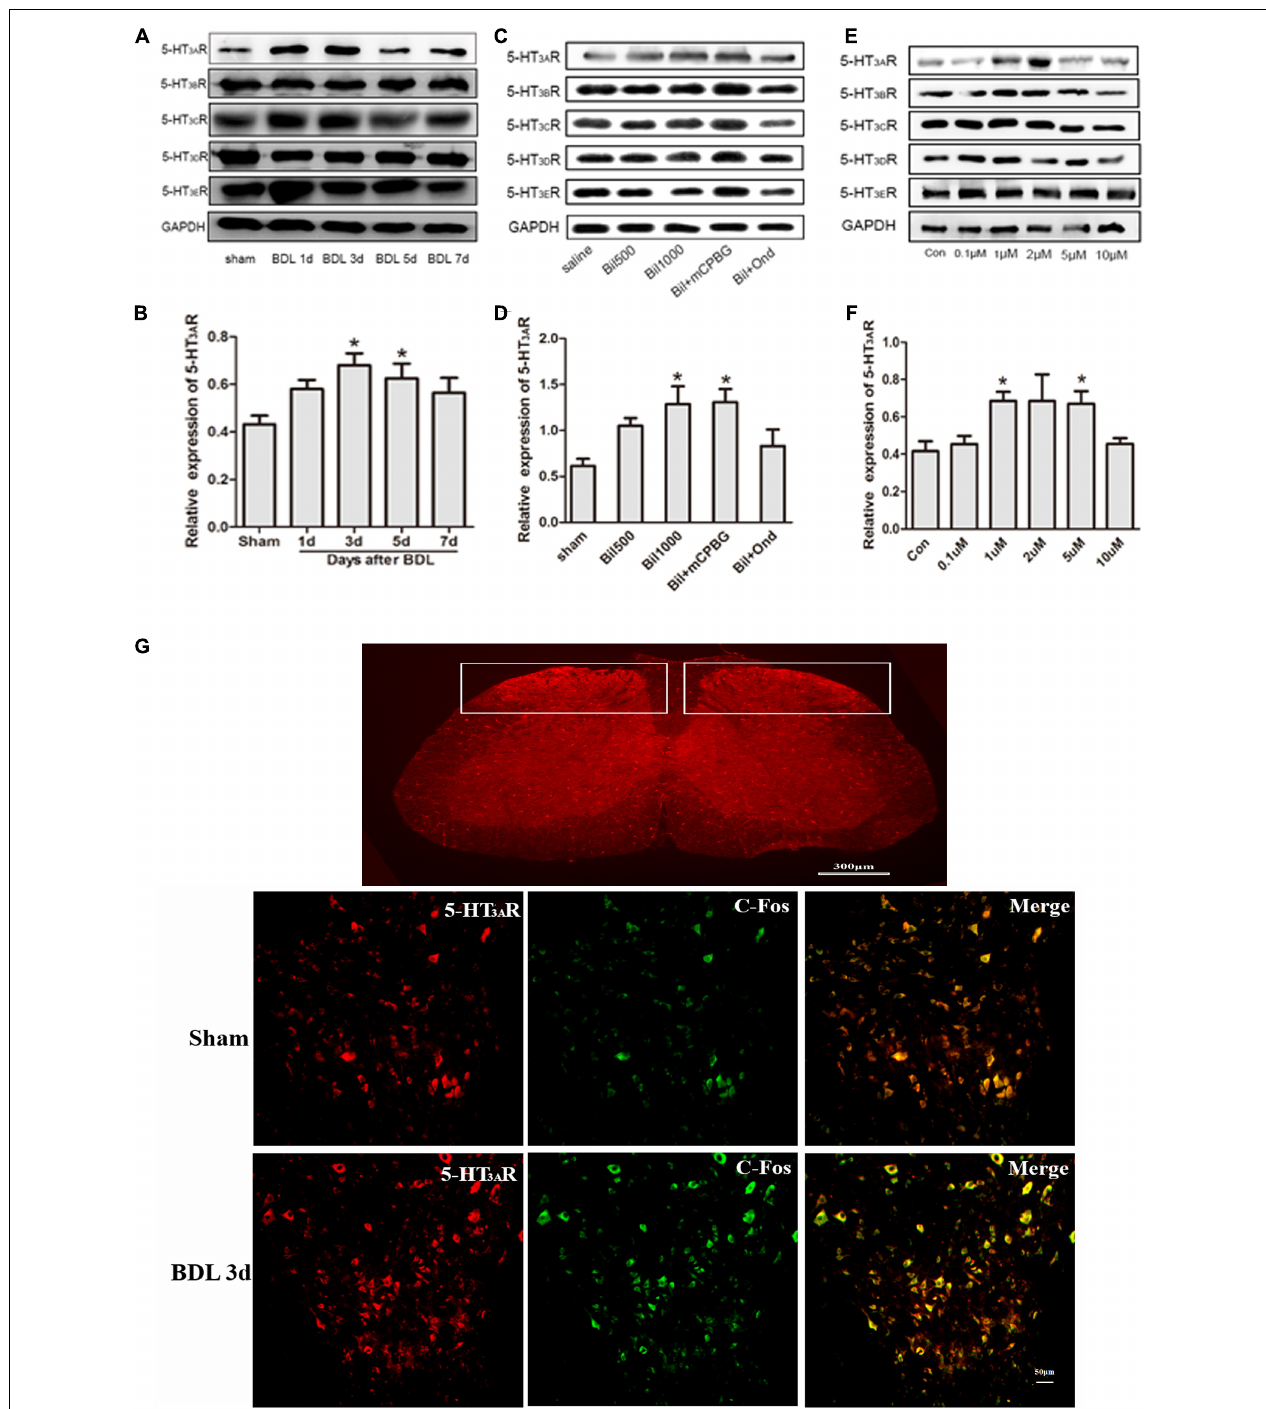
FIGURE 2 | Bilirubin increased 5-HT 3 A receptor expression and neuron activities in the spinal cord. (A) 5-HT 3 A receptor expression increased gradually in spinal cord enlargement of BDL rats, whereas expression of 5-HT 3 B , 5-HT 3 C , 5-HT 3 D , and 5-HT 3 E receptors did not change significantly. (B) The quantitative analysis of 5-HT 3 A receptor expression in BDL rats. (C) Intrathecal administration of bilirubin increased 5-HT 3 A receptor expression without changing other subtypes. (D) The quantitative analysis of 5-HT 3 A receptor expression after intrathecal administration of bilirubin in normal rats. (E) SDHNs cultured with bilirubin showed increased 5-HT 3 A receptor expression without changing other subtypes. (F) The quantitative analysis of 5-HT 3 A receptor expression in SDHNs. (G) Immunofluorescence showed that 5-HT 3 A receptor expression increased in laminas I and II in the spinal cords of BDL rats. The increased C-Fos protein (marker of neuron activity) expression indicated that neuron activities were also enhanced in the spinal cords of BDL rats. * P < 0.05.